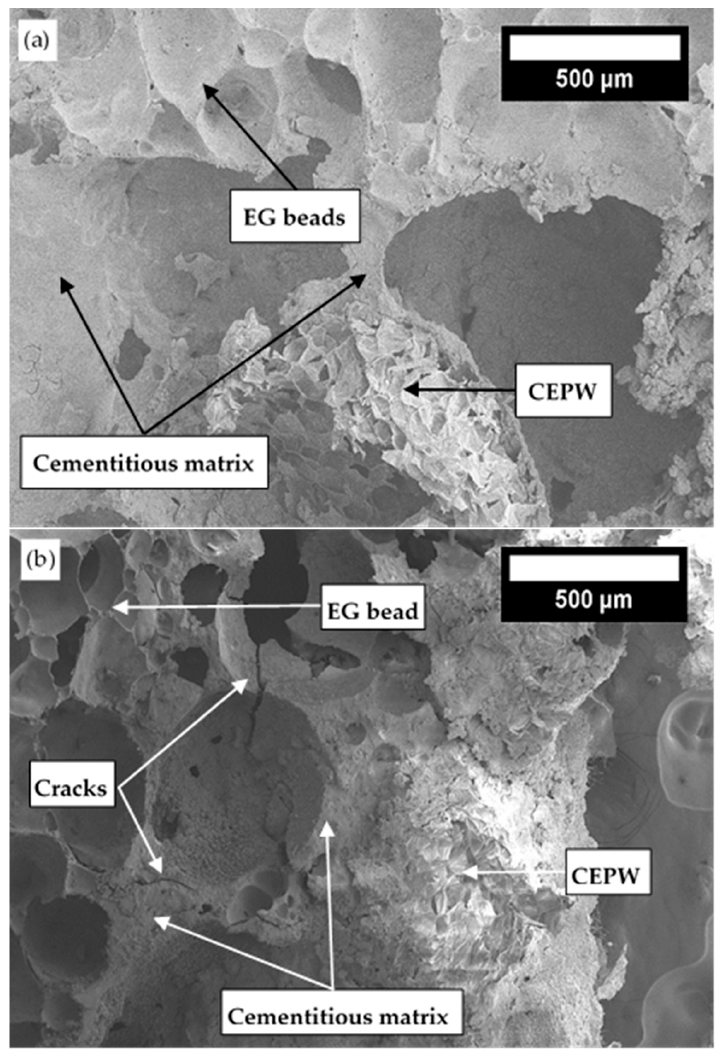
Figure 11. View of the LWC with mixed aggregate: ( a ) before freezing; ( b ) after 200 freeze–thaw cycles.